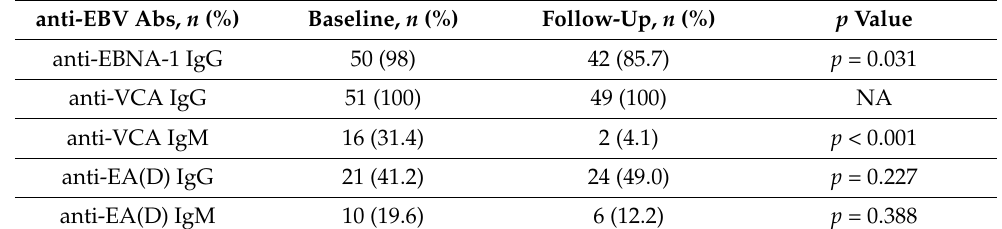
Table 3. Seroprevalence of anti-EBV antibodies during the follow-up.